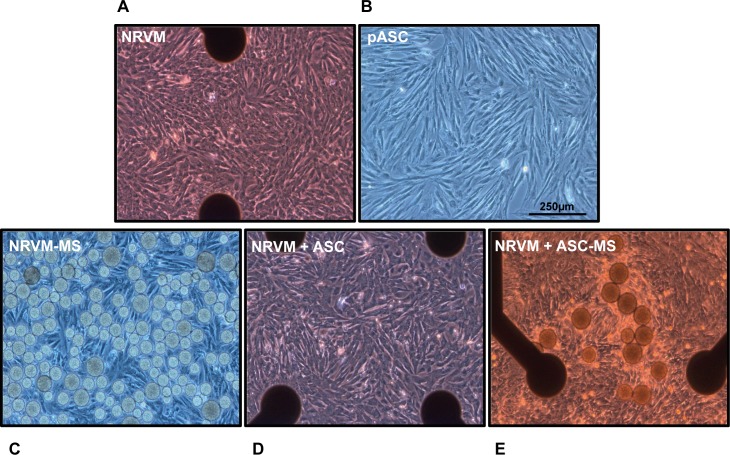
Light microscope image of the two main cell types used and the different cultures.A: Monolayers of NRVM cultured on multi-electrode arrays, B: Porcine ASC in culture, C: Monolayers of NRVM cultured together with microspheres, D: Co-cultures of NRVM and porcine ASC on a multi-electrode array and E: Co-cultures of NRVM and porcine ASC loaded on microspheres. Original magnification 10x. Black dots represent electrode terminals in the multi-electrode arrays. Abbreviations; ASC: adipose tissue-derived stromal cells, MS: microspheres and NRVM: neonatal rat ventricular myocytes.